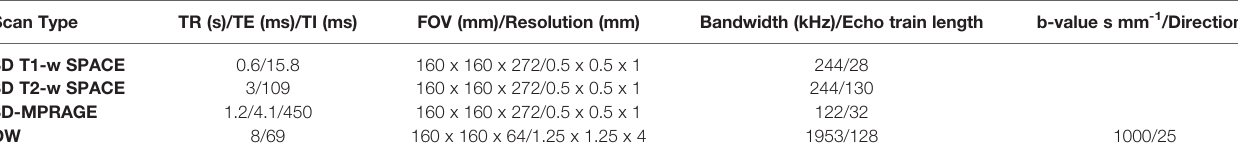
TABLE 2 | MRI acquisition parameters used immediately after insonation and at 7-day follow-up imaging. Scan